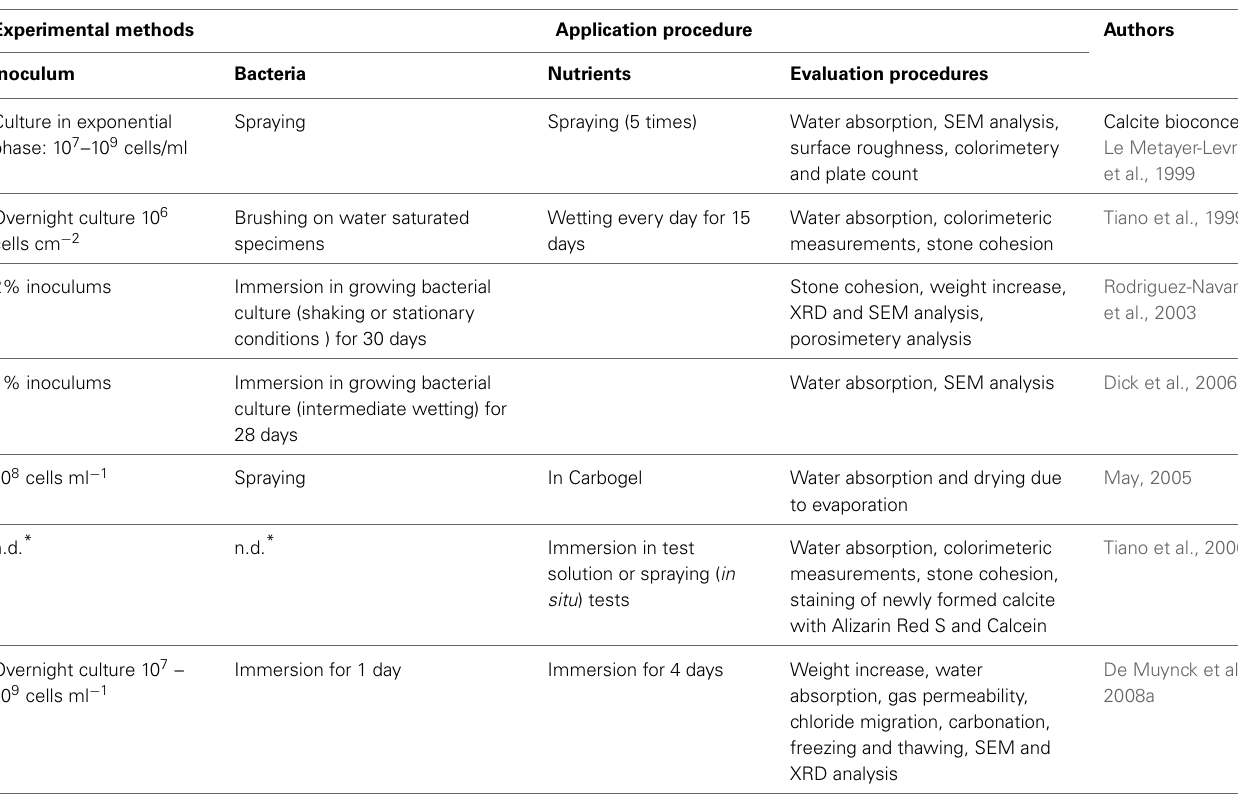
Table 3 | Overview of different methodologies where microbial calcite has been deposited as a layer on surface of stone. Experimental